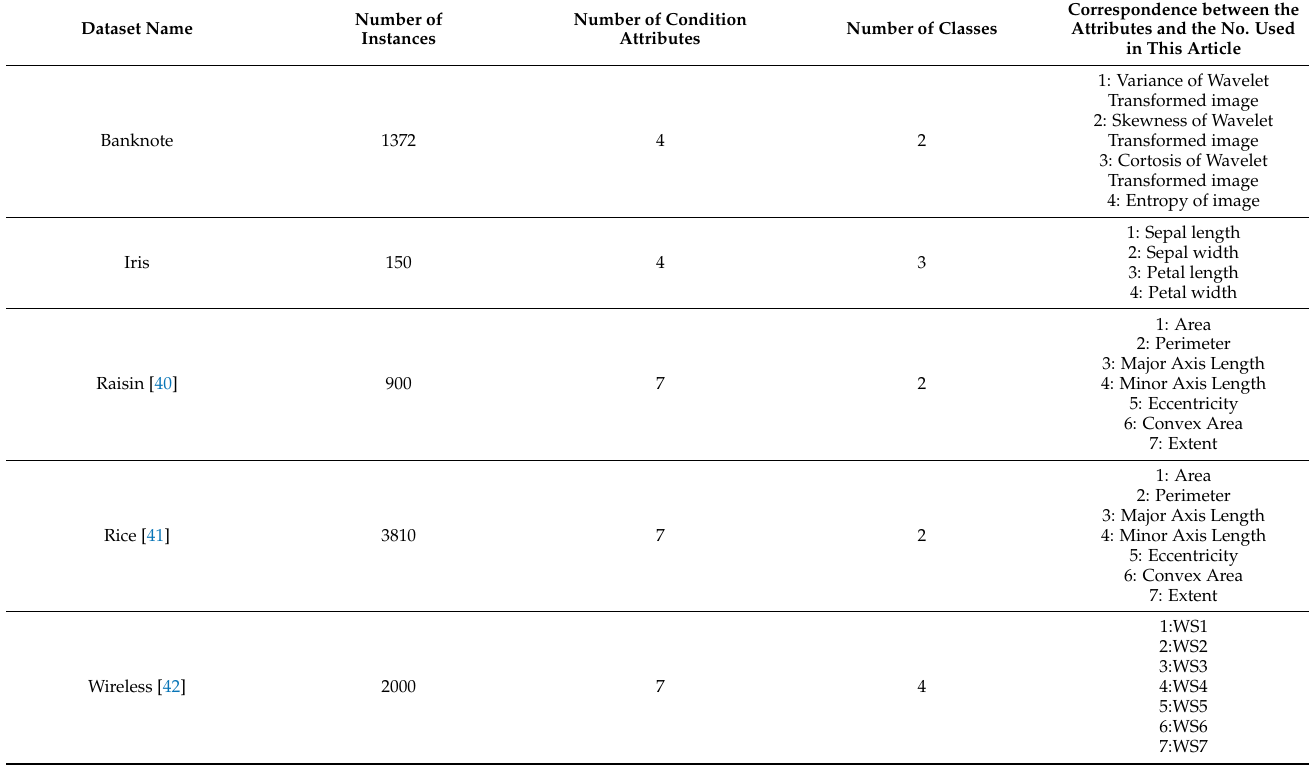
Table 2. UCI dataset used in the